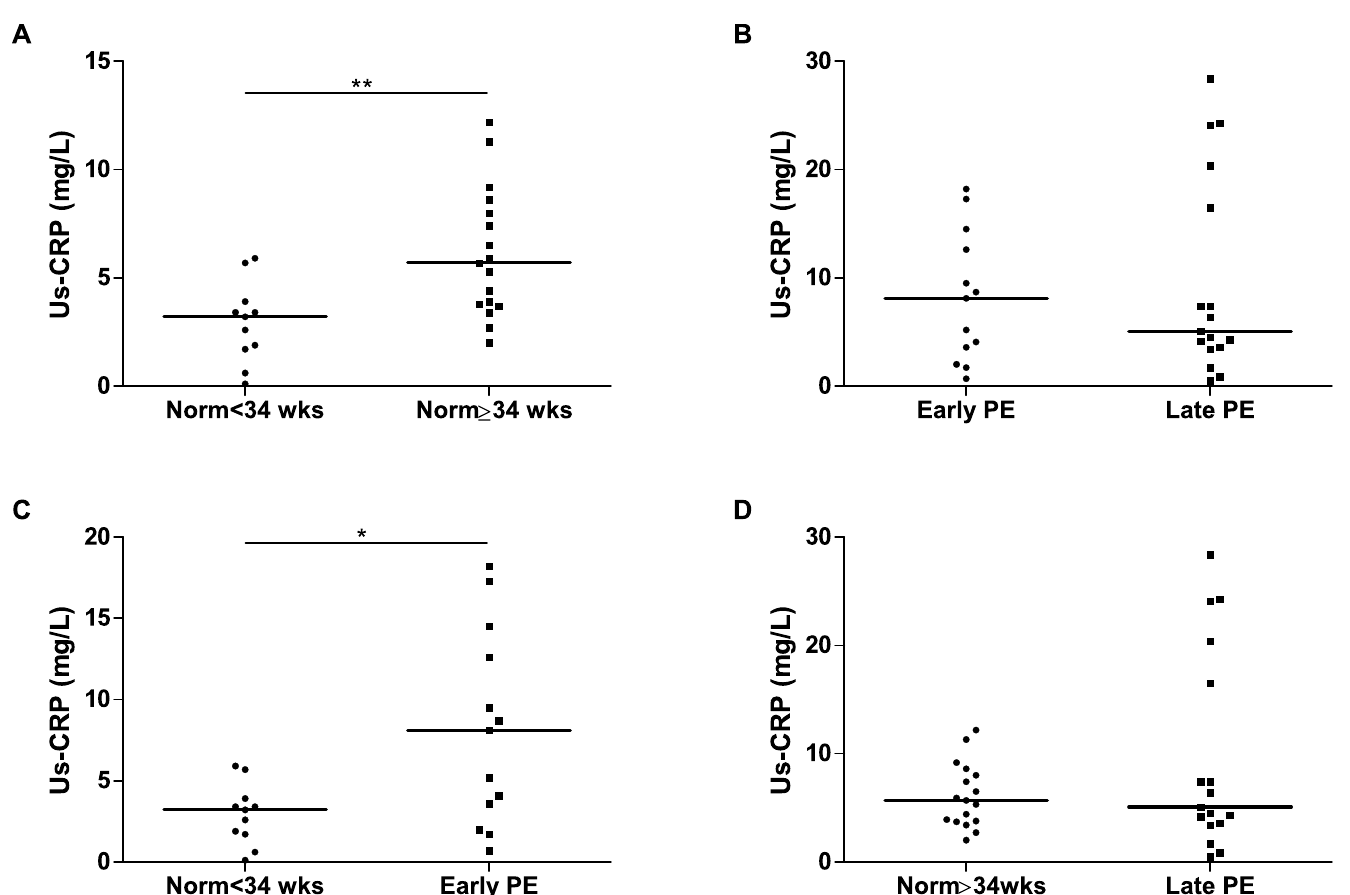
Fig 5. us-CRP plasma levels in normotensive pregnant and PE women according to gestational age. Norm < 34 wks (normotensive pregnant women with GA < 34 weeks), Norm (cid:1) 34 wks (normotensive pregnant women with GA (cid:1) 34 weeks), PE (preeclamptic women). Horizontal bars represent median us- CRP levels (milligrams/liter). * P < 0.05. Plasma levels of us-CRP were higher in normotensive pregnant women (GA (cid:1) 34 weeks) than in normotensive pregnant women (GA < 34 weeks) (A). Pregnant women with early PE had higher levels of us-CRP than normotensive pregnant women with GA < 34 weeks (C). No significant differences were found between pregnant women with early and late PE (B) and between pregnant women with late PE and normotensive pregnant women GA (cid:1) 34 weeks (D).